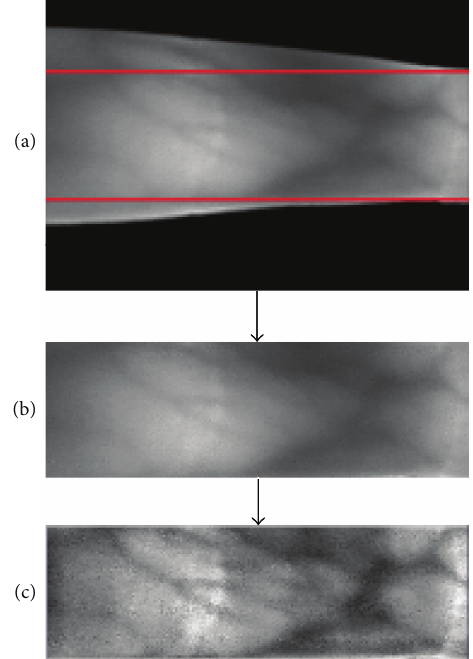
Figure 4: A sample of ROI localization: (a) acquired image, (b) ROI image, and (c) enhanced